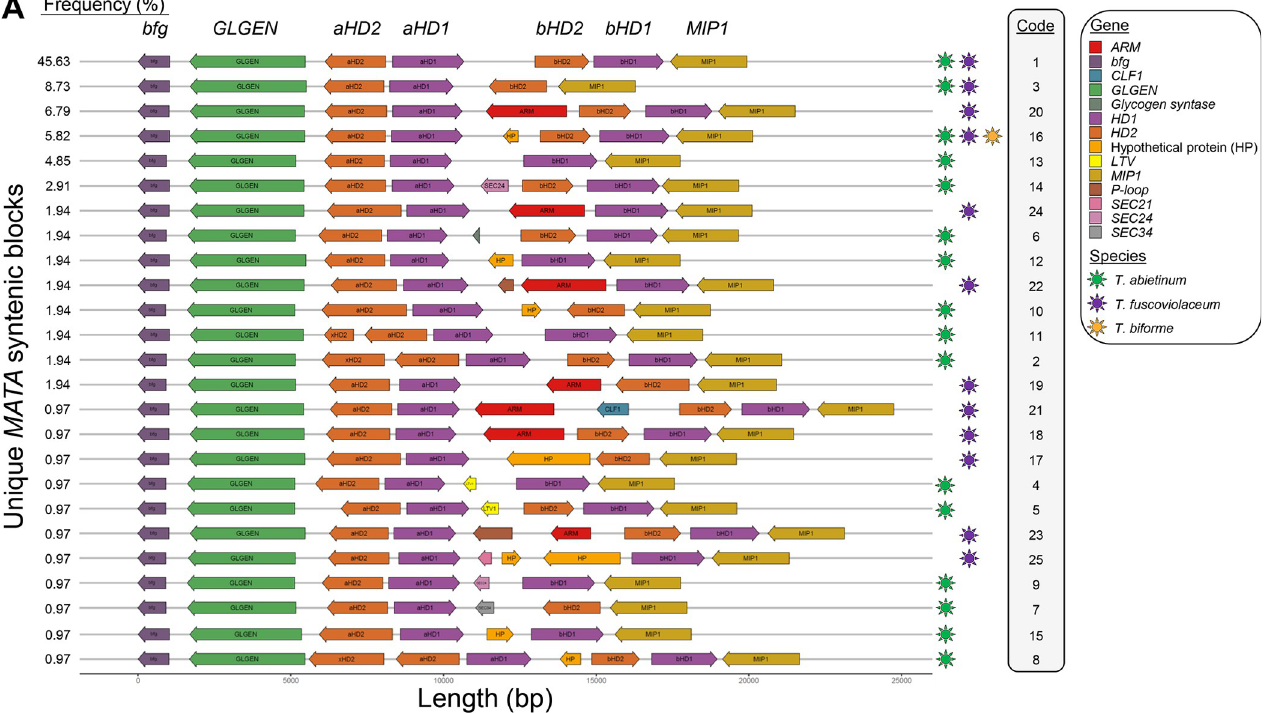
Fig 5. Mating A region is highly dynamic and show multiple rearrangements among Trichaptum strains. MATA gene order representations for Trichaptum strains with MATA genes assembled in one contig. The percentage of strains containing a specific MAT block order is indicated in the left. Genes were colored according to the legend on the right. Species containing a particular MAT block are represented by colored stars at the right of the MAT block and were colored according to the legend. Coding sequence direction is represented by the arrows. Code numbers link the strains in S2 Table with the displayed mating structure.